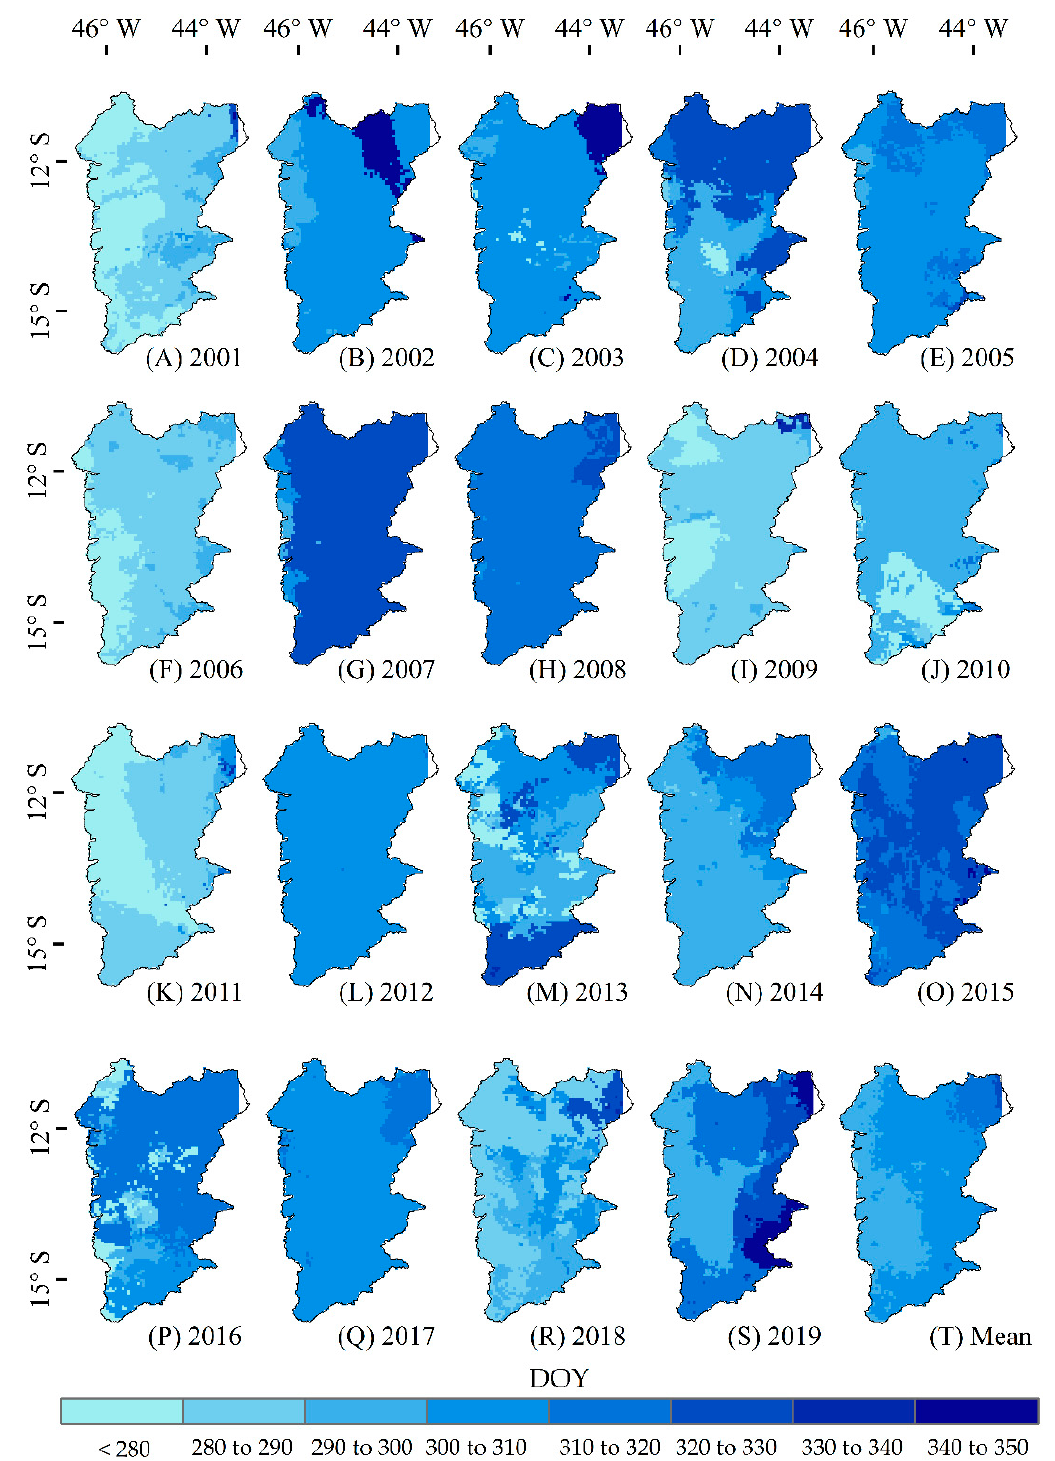
Figure 6. Rainy season onset dates in Western Bahia from 2001 to 2019 (( A )–( S )). Panel ( T ) shows the average onset date for each pixel.